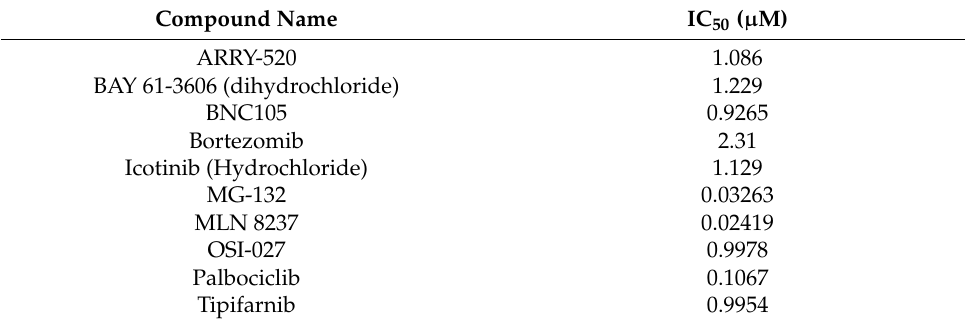
Table 3. List of IC 50 values for top 10